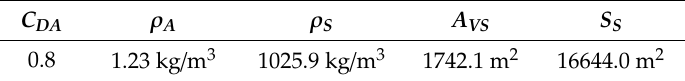
Table 6. Comparison of resistance coe ffi cients with and without